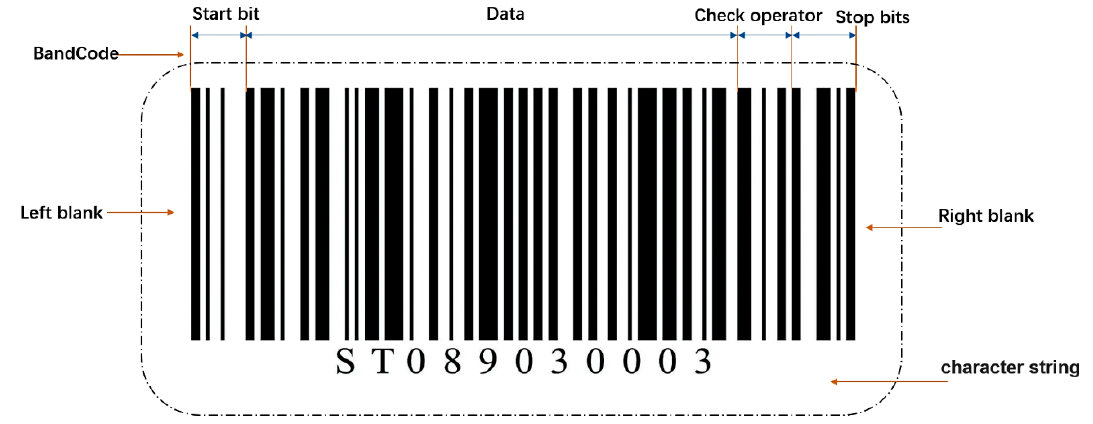
Figure 6. Diagram of bar